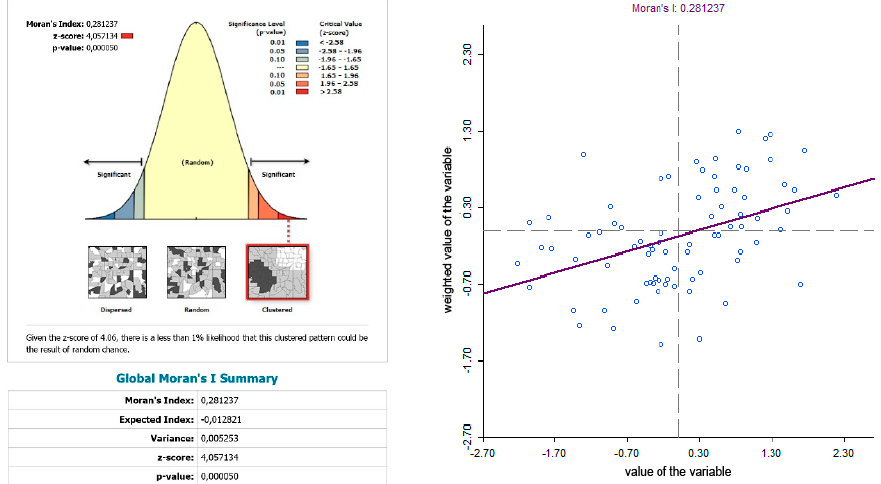
Figure 3. Final statistics and Moran ′ s diagram for standardized death rate of breast cancer per 1000 inhabitants of European Standard Population 2001–2006. Source: Statistical Office of the Slovak Republic, 2019.